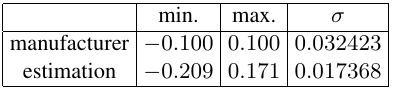
Table 4: Statistics of the point-to-plane misclosure (unit: [m]).